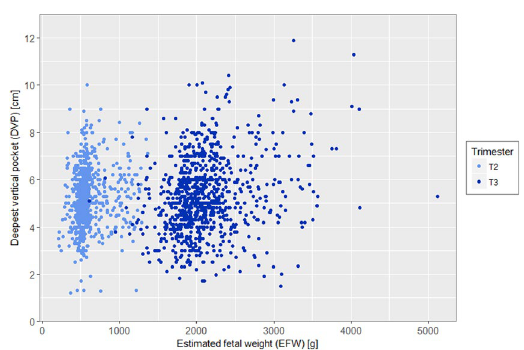
Figure 4. Distribution of amniotic fluid index (AFI) according to estimated fetal weight (EFW) and stratified by 2nd (18–28 weeks) and 3rd (29–40 weeks) trimester of